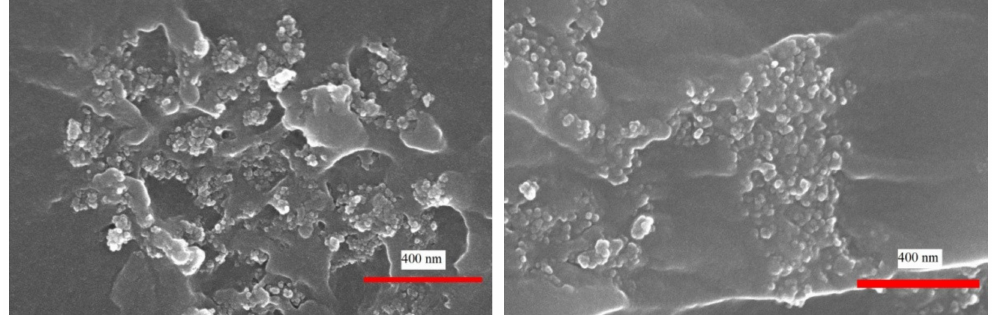
Figure 13. Scanning electron microscopy images of composites with 10 wt.% of OLC particles of size 40 nm (left) and 220–250 nm